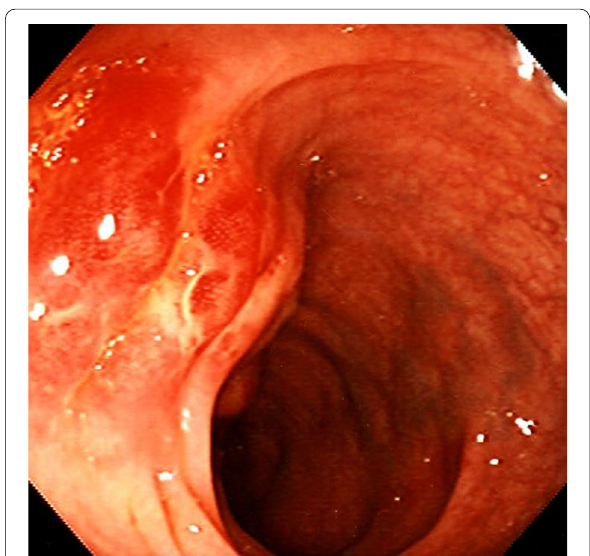
Fig. 3 Colonoscopy demonstrating a red, raised wheal with a minute ulcer in the transverse colon, indicating submucosal invasion of an extramural tumor. Endoscopic biopsies revealed inflammation with no malignancy